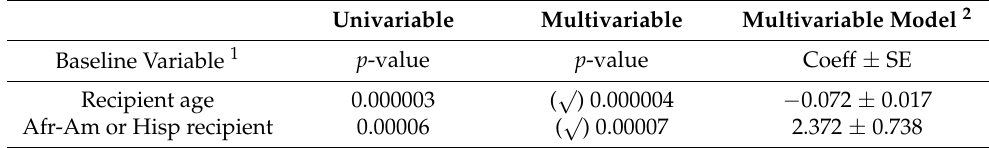
Figure 4. Cumulative hazard plot of NA occurrence for all patients combined. Table 5. Cox model results for the hazard rate of becoming nonadherent (28